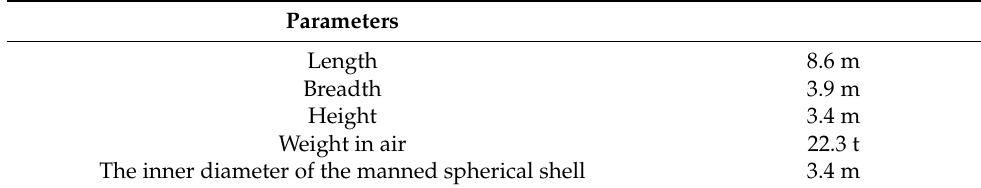
Table 1. Parameters of the Jiaolong manned